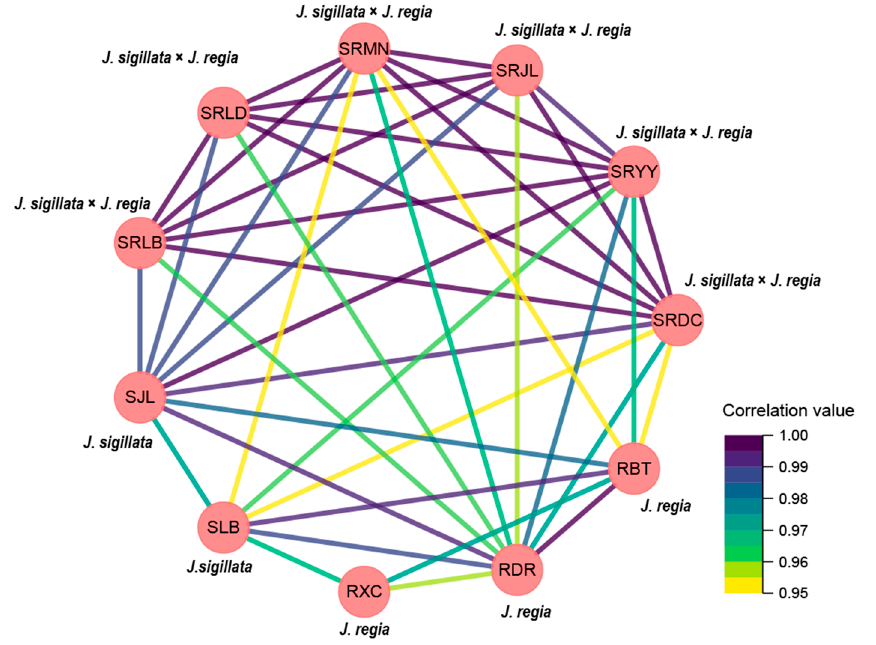
Figure 4. The related network diagram of cultivation sites/species and the main composition of walnut oil.